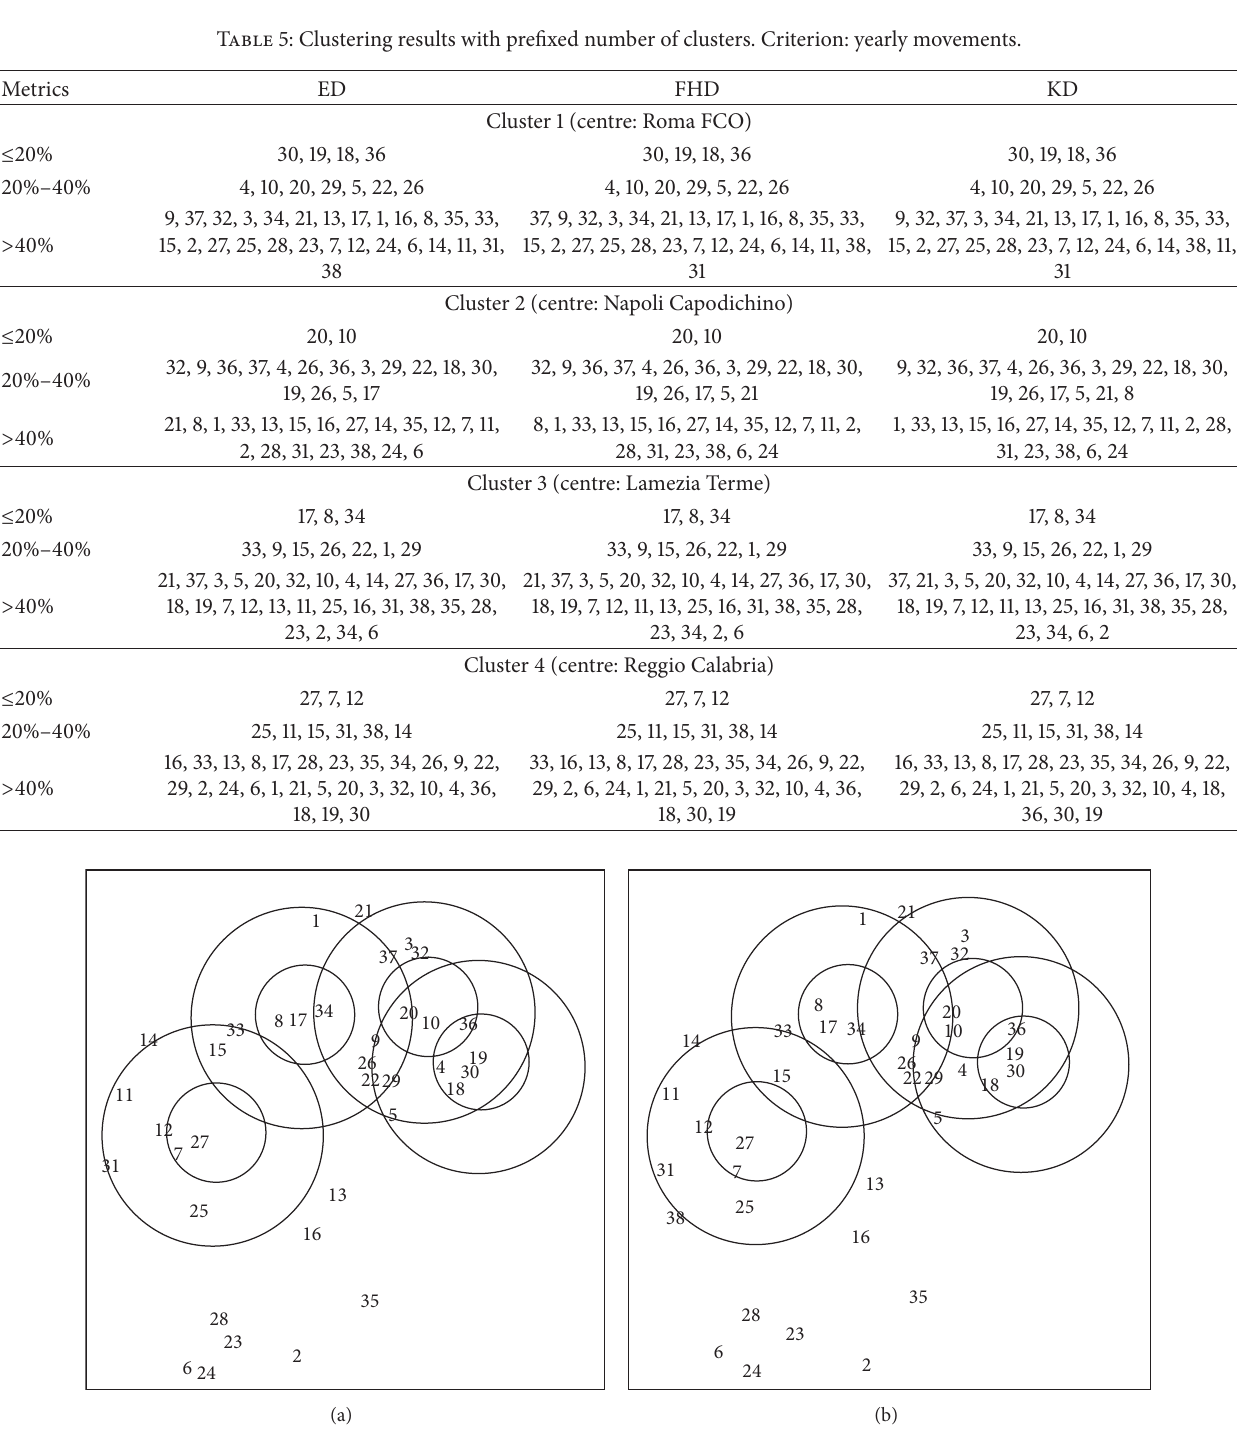
Figure 3: Representation of clusters (Tables 3 and 5—passengers and movements criteria with Euclidean